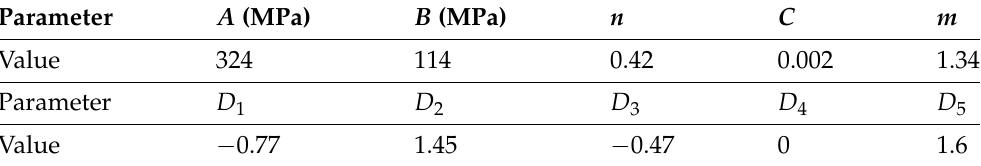
Table 3. Johnson–Cook parameters of workpiece (Al 6061) [29,34].